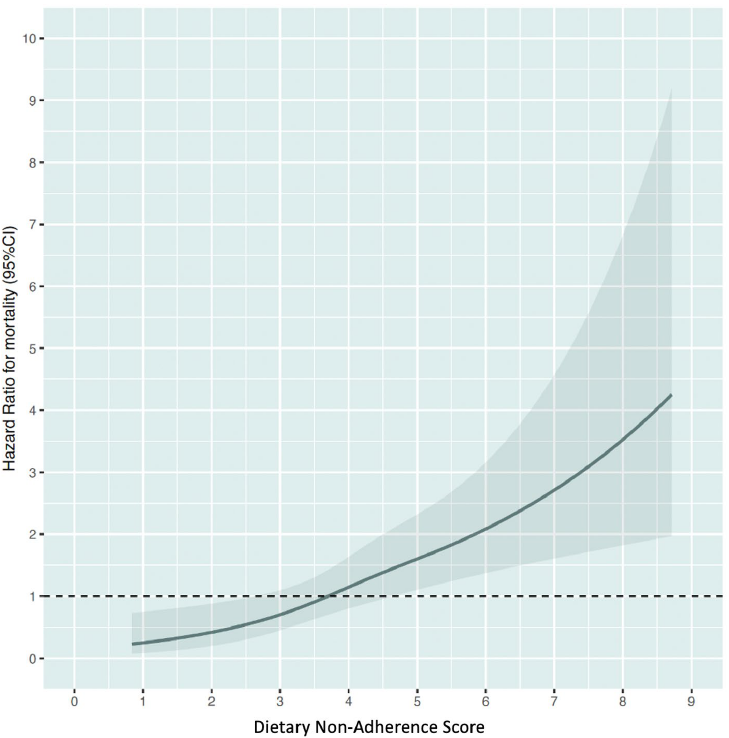
Figure 2. Relationship between Dietary Non-Adherence Score and the risk of all-cause mortality. Estimated from restricted cubic spline Cox regression modelling.